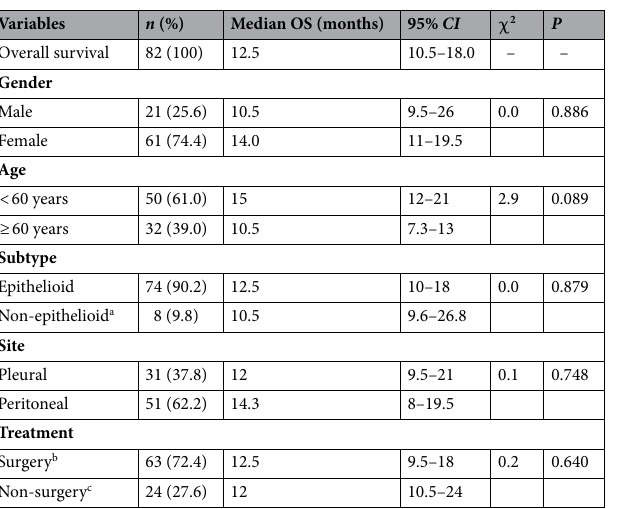
Table 1. Demographics of mesothelioma patients. OS: overall survival. a Including the patients with biphasic or sarcomatoid subtype. b Including the patients undergoing chemotherapy after surgery. c Including the patients undergoing chemotherapy, radiotherapy or no special